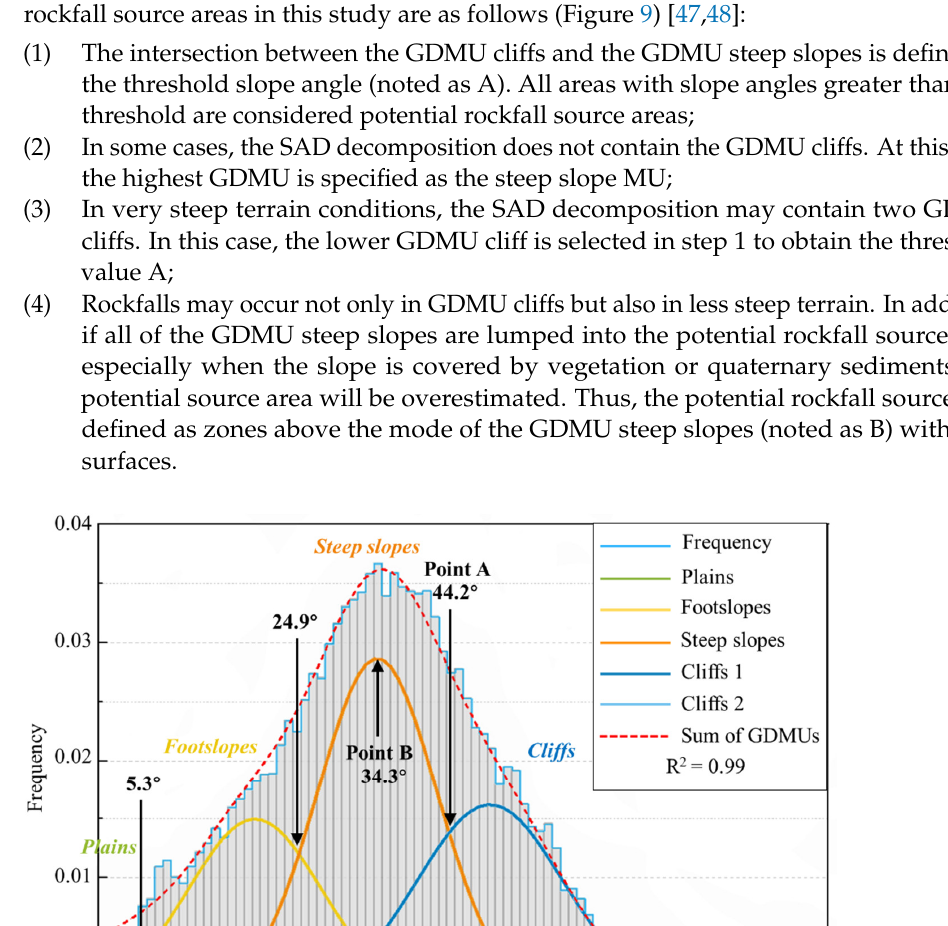
points A and B are directly controlled by the topographic and geomorphological condi- tions of the study area [27]. The literature review results indicate that the threshold ranges of points A and B are (25°, 61°) and (18°, 44°), respectively [19,47–49]. As the SAD method only uses the topographic information embedded in the HRDEM to identify the potential rockfall source areas, the above method is referred to as static identification of the rockfall source areas, and the results obtained are the static rockfall source areas. 3.1.2. Activity Identification of Potential Rockfall Source Areas at the Regional Scale To obtain more reliable deformation results, Berardino et al. [50] proposed the SBAS- InSAR technique, which can effectively reduce the influence of spatiotemporal decoher- ence and atmospheric delay and increase the temporal sampling frequency. The basic principle of the SBAS-InSAR technique is to use image pairs with short spatiotemporal baselines to generate interferograms to improve interferometry and then perform the phase-unwrapping of the SAR interferograms [51]. The specific technical flowchart of the SBAS-InSAR technique is shown in Figure 10.